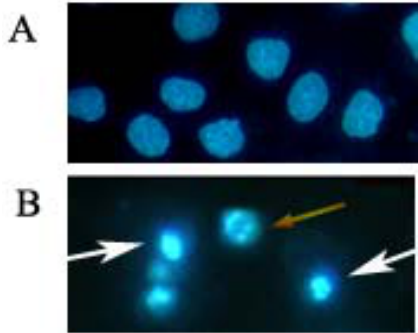
Figure 3. Morphological observation of HOS cells treated with 4 μ M daphnoretin for 48 h by inverted fluorescence microscopy. Cells undergoing apoptosis and nuclear fragmentation are indicated by arrows. A, Untreated cells; B, daphnoretin-treated cells. The experiments were repeated three times and representative photographs are